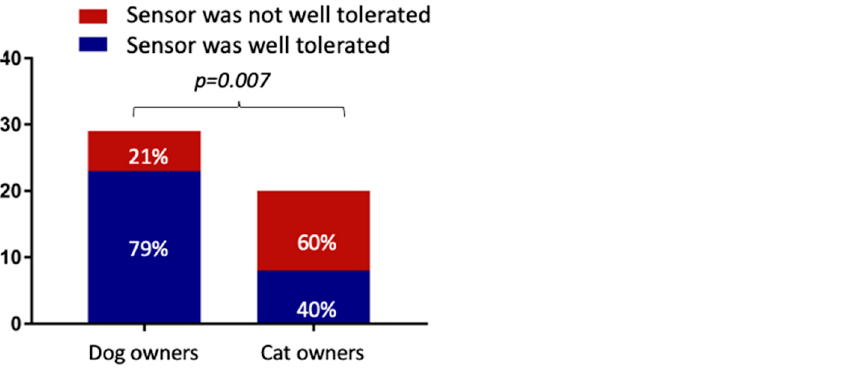
Figure 4. Comparison of dog and cat owners’ points of view regarding the tolerability of the sensor.